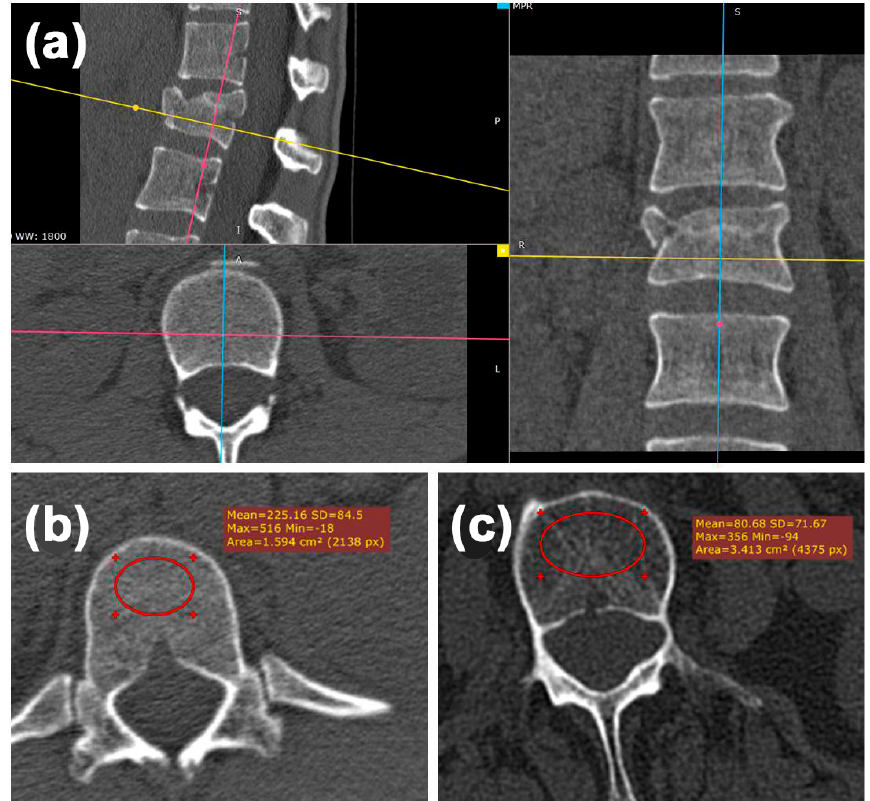
Figure 2. Hounsfield unit measurements in the broken vertebra, the one above and below, following the reported algorithm. ( a ) The axis have been adapted using a multiplanar reconstruction, the correct alignment was checked sagittal (blue line), transversal (yellow line) and coronal (pink line) and corrected if necessary. Subsequently, the measurements were performed in the axial slice within the defined regions of interest (red circles). ( b ) A non-osteoporotic vertebra with a mean Hounsfield unit (HU) of 225.16. ( c ) An osteoporotic vertebra with a mean HU of 80.86.